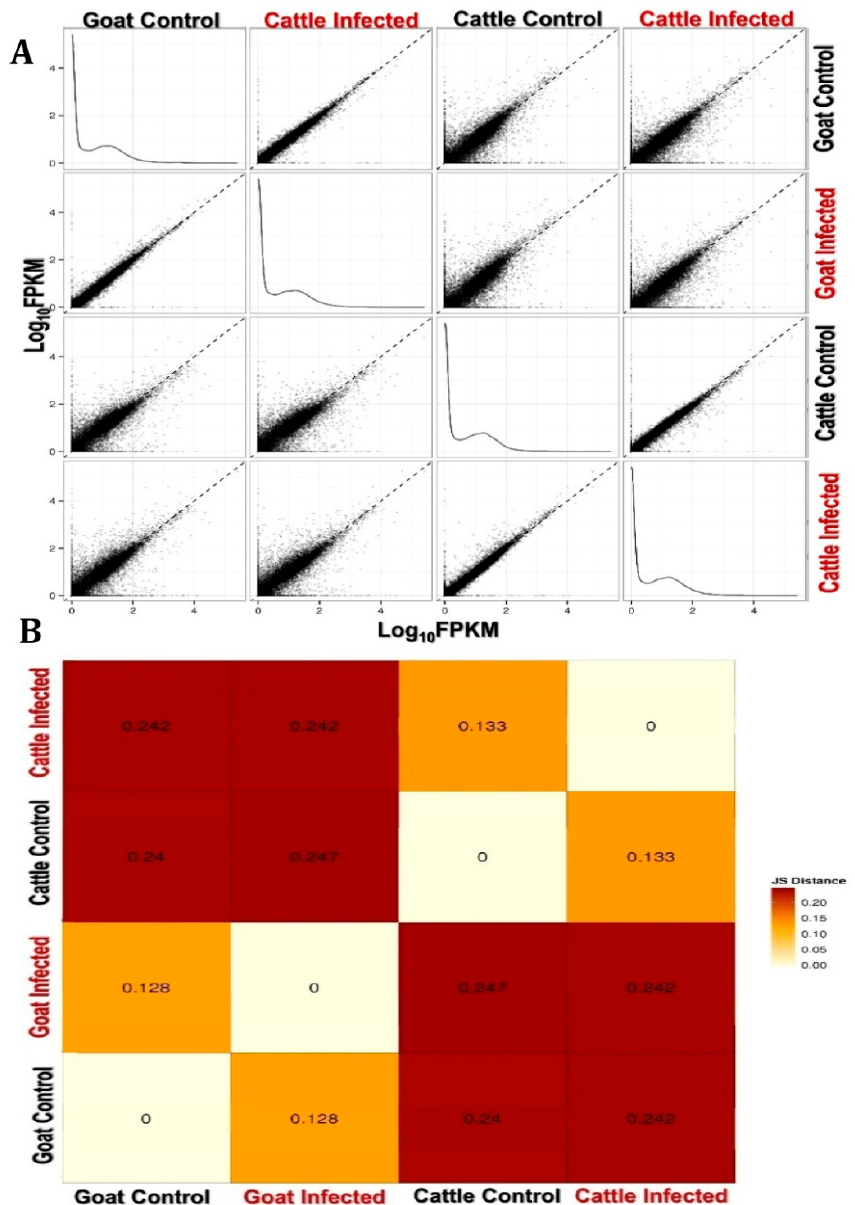
Figure 2. Correlation scatter and Distance Matrix plot of the estimated gene-expression across the samples compared in this study. ( A ) The estimates of the gene expression was performed using cufflinks and expressed as FPKM. The correlation scatter is depicted as Log 10 FPKM across the samples. ( B ) The pairwise similarities across the samples are depicted as a matrix plot. Note: Both the scatter and the matrix plot clearly indicates the existence of a basal difference in the transcripts across goat and cattle PBMC as well as transcripts that are differentially regulated upon infection with PPRV.